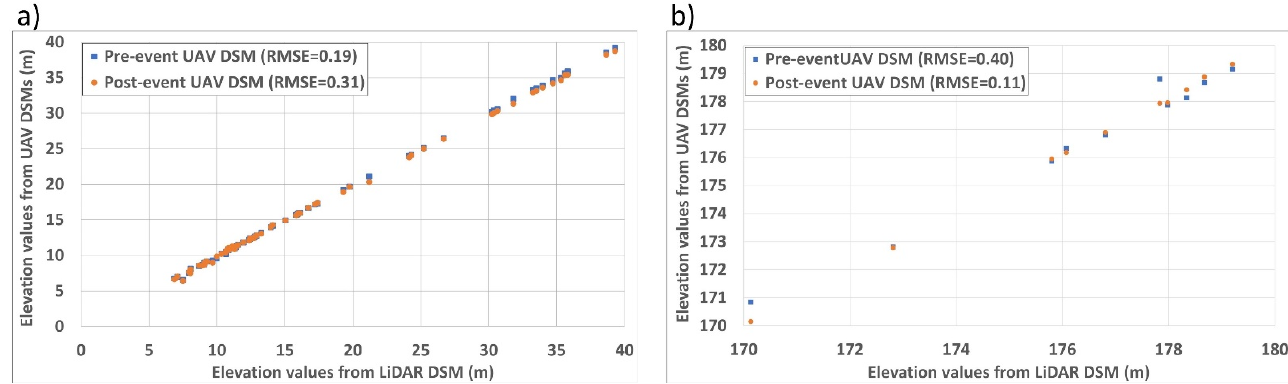
Figure 12. ( a ) Elevation values of LiDAR DSM versus that of UAV DSMs for Coulibistrie. The RMSE between these datasets are given in legend. The elevation values were extracted from 67 points. ( b ) Elevation values of LiDAR DSM versus that of UAV DSMs for Pichelin. The RMSE between these datasets are given in legend. The elevation values were extracted from 10 points.